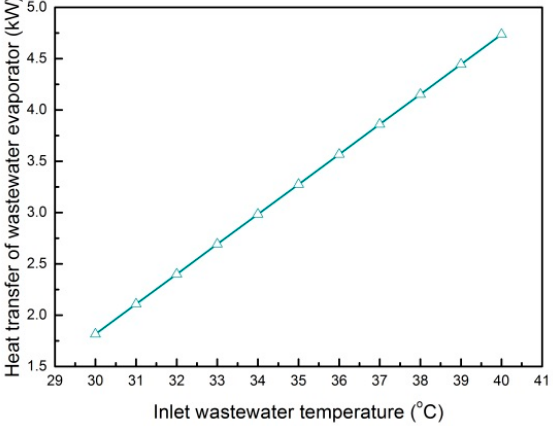
Figure 5. Influence of inlet wastewater temperature on heat transfer of wastewater evaporator.